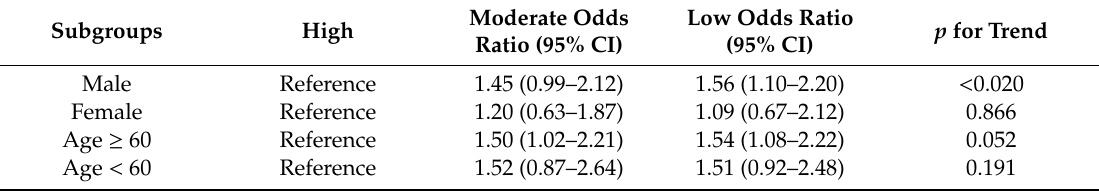
Table 4. Risk of renal progression across di ff erent levels of physical activity by gender and